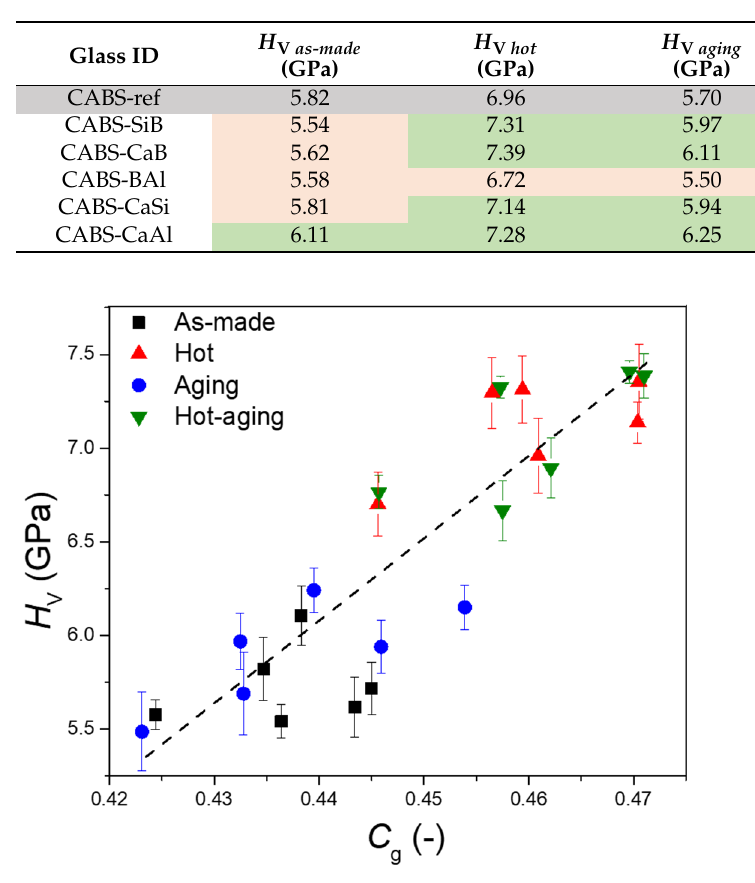
Figure 1. Relationship between Vickers hardness ( H V ) and atomic packing density ( C g ) of the CABS glasses subjected to different post-treatment. The dashed line is a guide to the